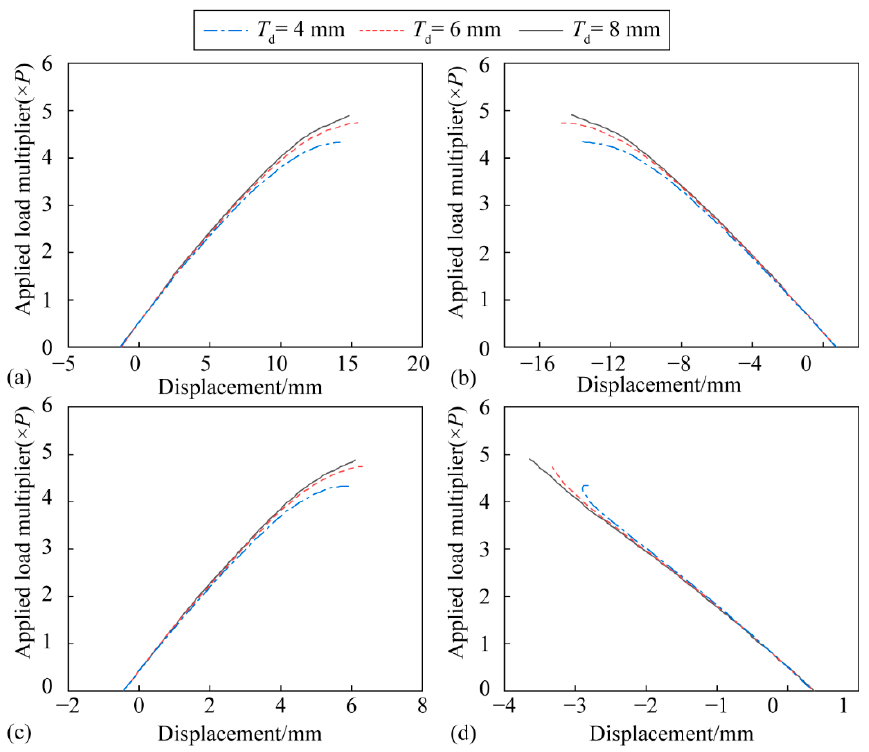
Figure 16. ( a ) Vertical displacement on the top flange, ( b ) horizontal displacement on the front web of the point in the juncture node zone, ( c ) vertical displacement on the top flange, ( d ) horizontal displacement on the front web of the point in the curved zone due to the change in the thickness of the diaphragm.